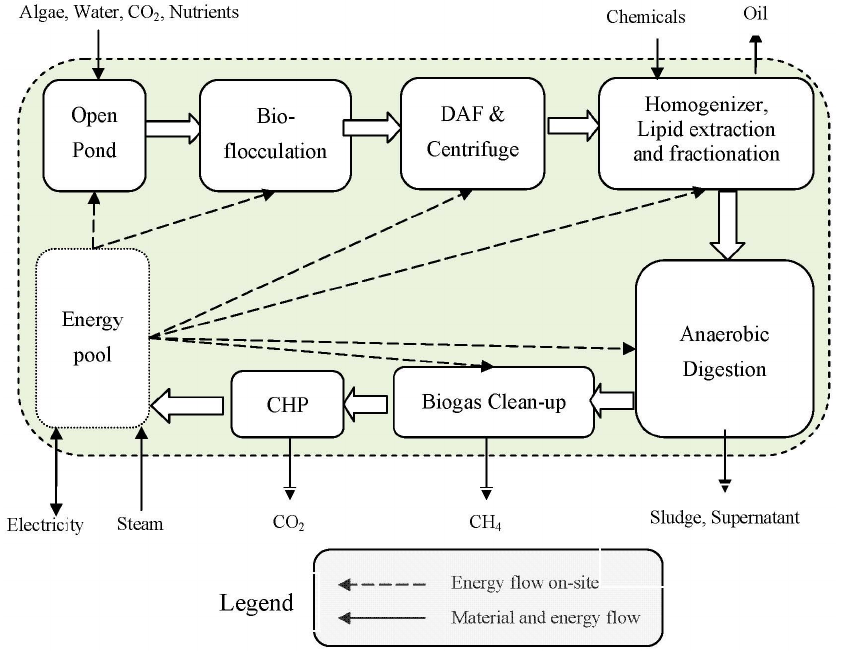
Figure 2. Baseline algae oil production